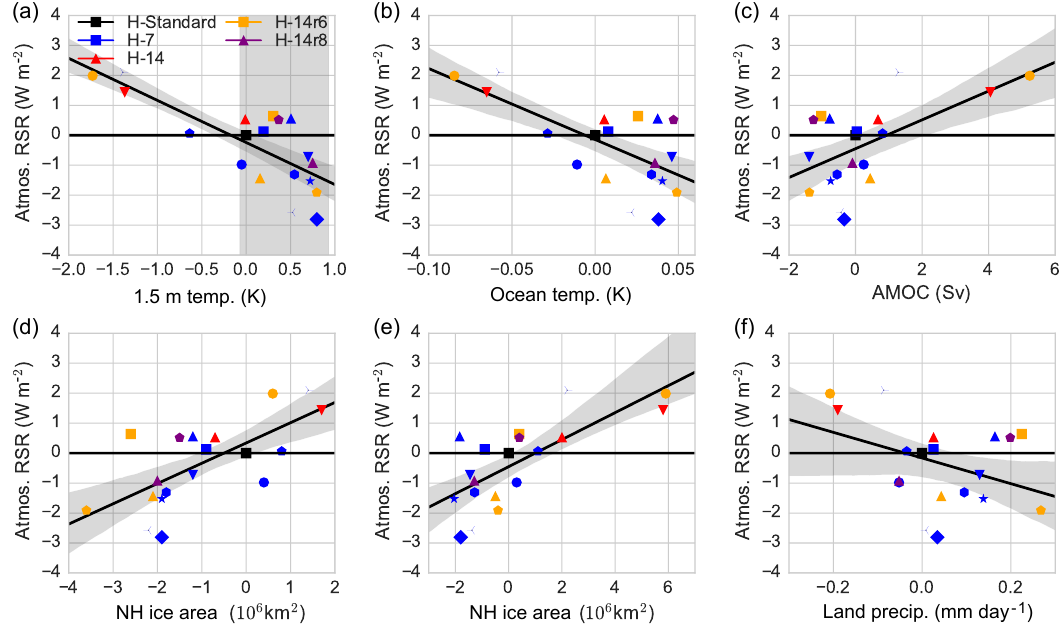
Figure 8. Scatter plot (symbols as in Fig. 1; colours in key) of optimal minus standard configurations for 2000–2010 mean RSR from atmospheric-only simulations against the coupled control mean for years 10–19 of 1.5m temperature (a) , volume average ocean tempera- ture (b) , coupled Atlantic Meridional Overturning Circulation (c) , Northern Hemisphere area where snow mass is > 6kgm 2 (d) , Northern Hemisphere ice area (e) and land precipitation (f) . Black lines and grey regions show best-fit regression line and 90% confidence interval on the regression lines. Vertical grey region in subplot (a) show the difference between pre-industrial global-average air temperatures and the standard configuration; configurations in this region are